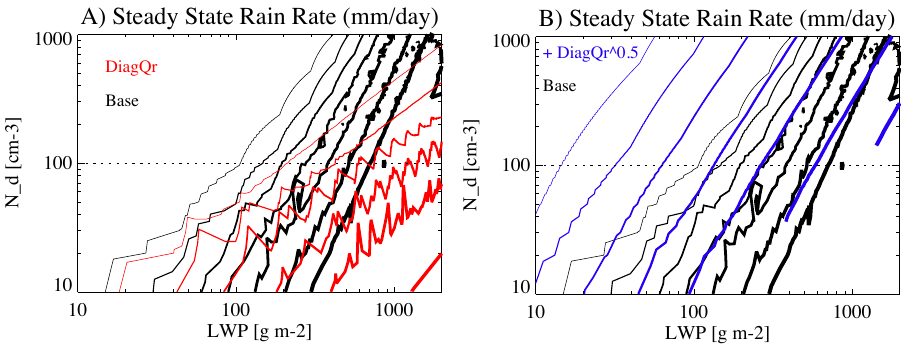
Fig. 2. Results from steady-state model of Wood et al. (2009). Rain rate (mmday − 1 ), contour lines at 0.03, 0.1, 0.3, 1, 3, 10 and 30 mm day − 1 . Thicker lines are higher rain rates. Cases shown: (A) base case (Black) and Diagnostic rain case (DiagQr, Red). (B) Base case (Black) and diagnostic rain with vertical variation of rain rate from autoconversion (DiagQr 0 . 5 : Blue) as described in the text.